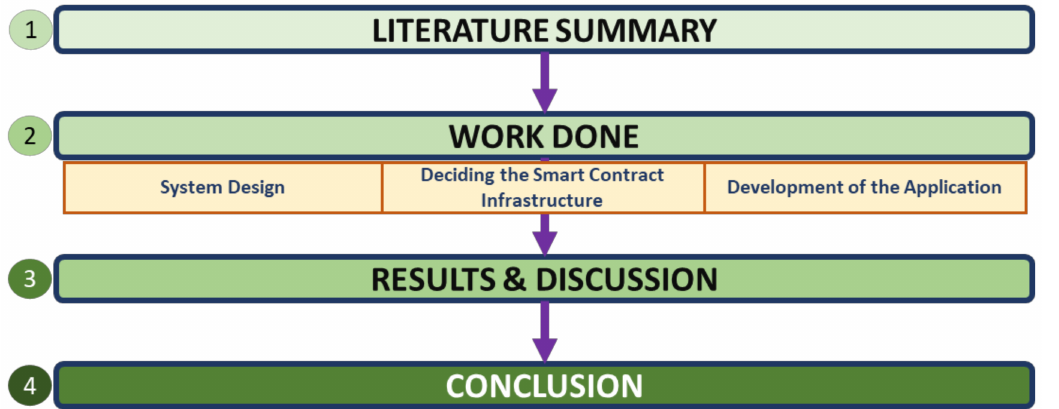
Figure 1. The methodology of the